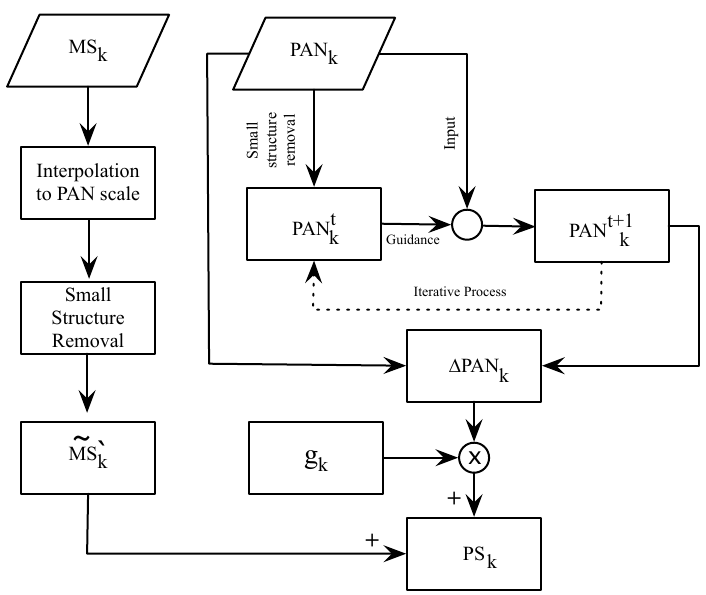
Figure 2. Workflow of the pansharpening (PS) proposed method based on the rolling guidance filter (PSRGF). MS k and PAN k are the k -th band of the MS and histogram-matched PAN images and PAN t + 1 the last update of the RGF iteration